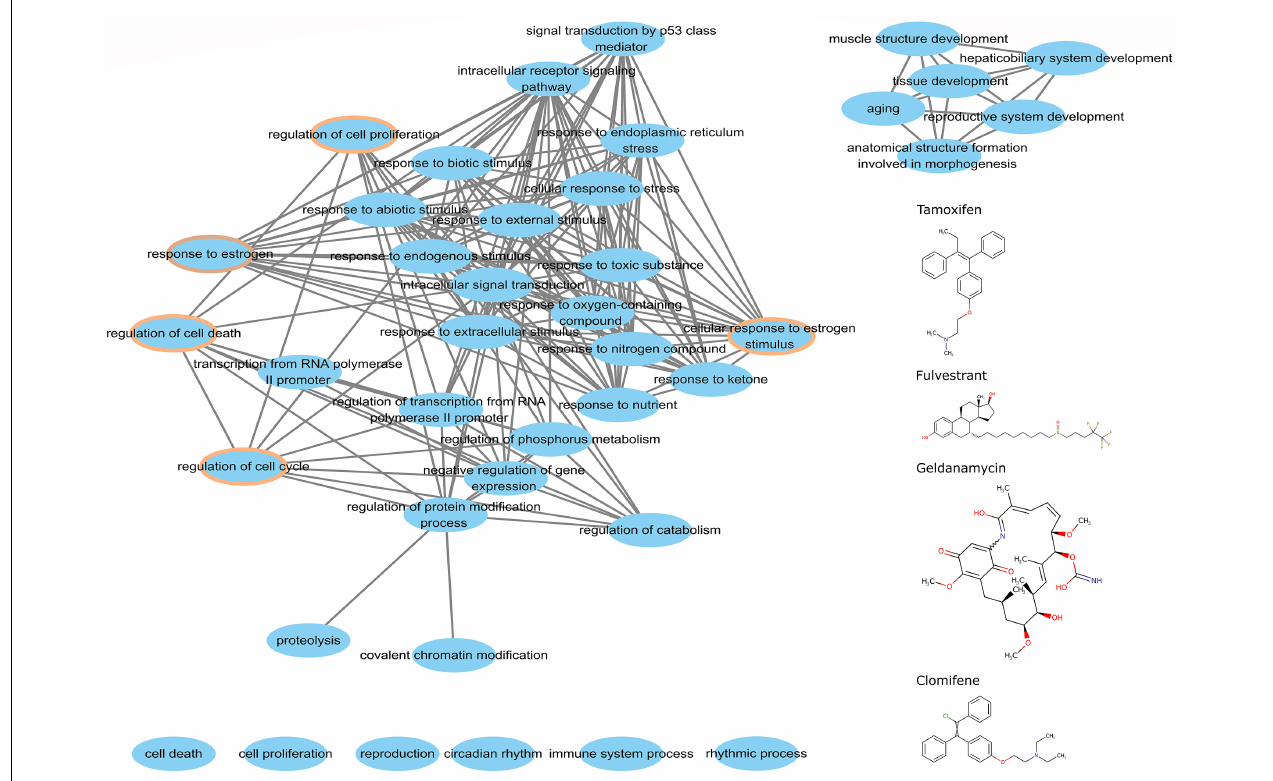
FIGURE 7 | The common biological process of perturbed genes in the major cluster. The chemical structures of tamoxifen, fulvestrant, geldanamycin, and clomifene are on the right. The brown circle denotes the functional processes related to cell growth and